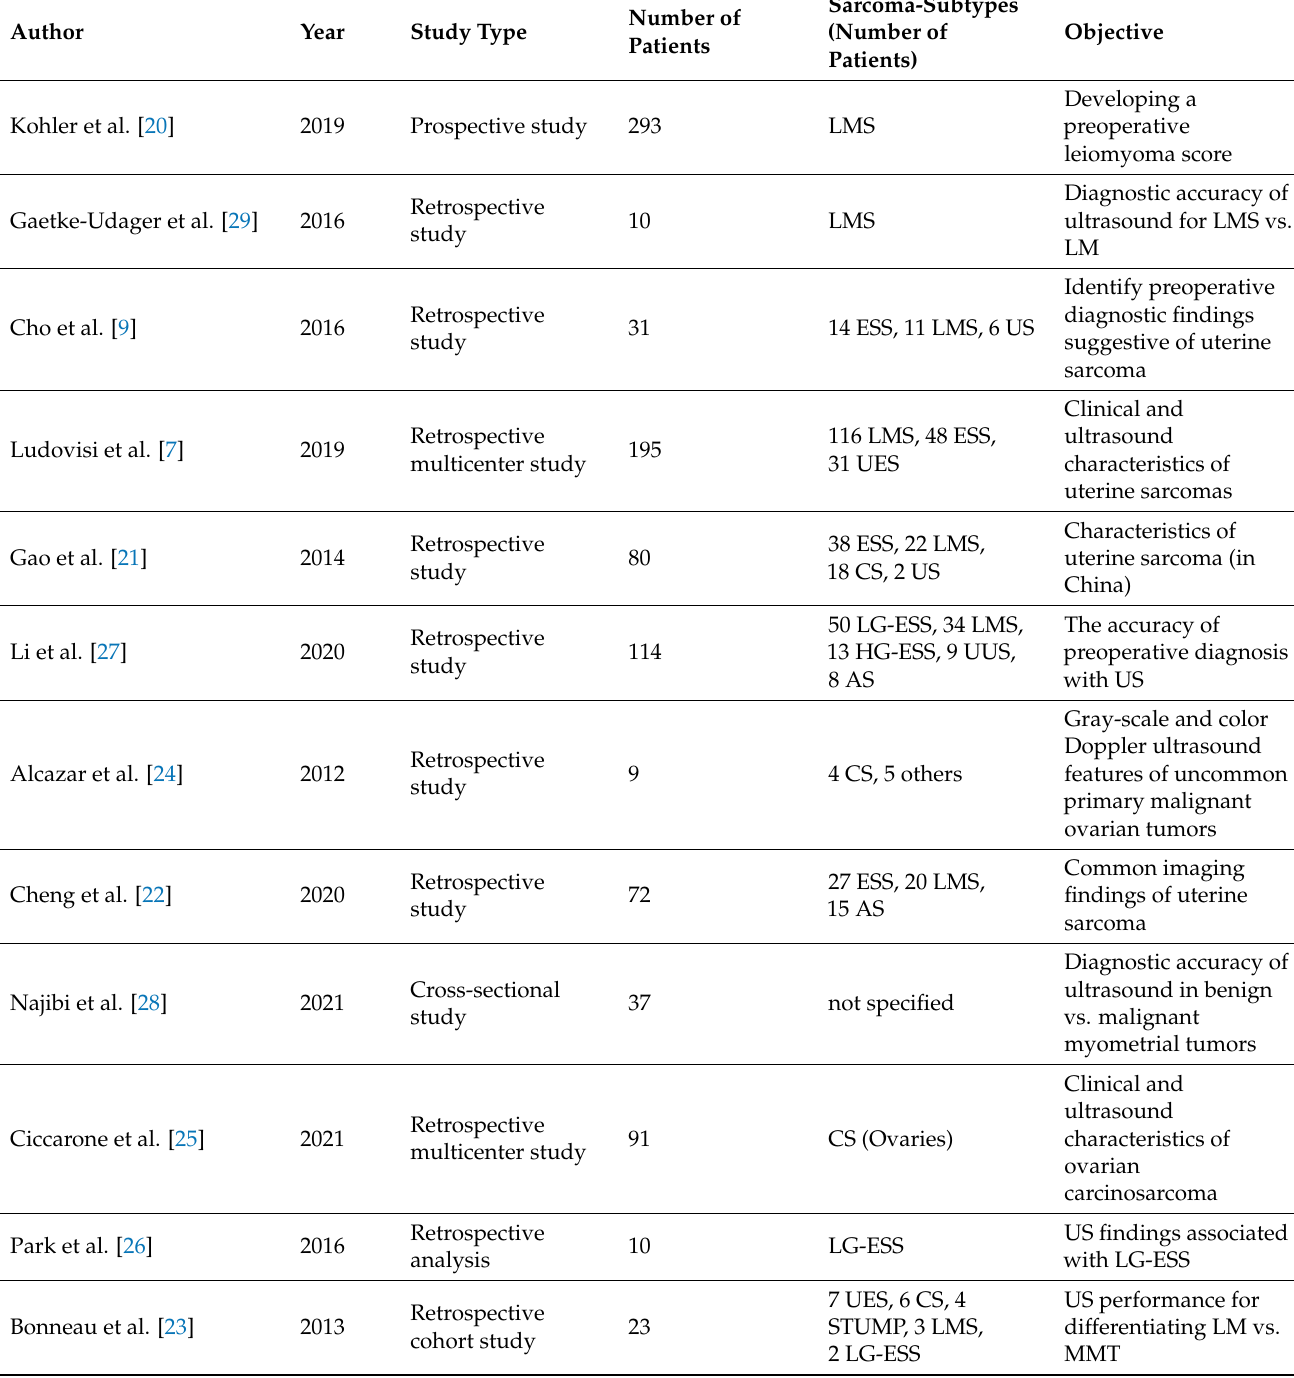
Table 1. Overview of reviewed studies on